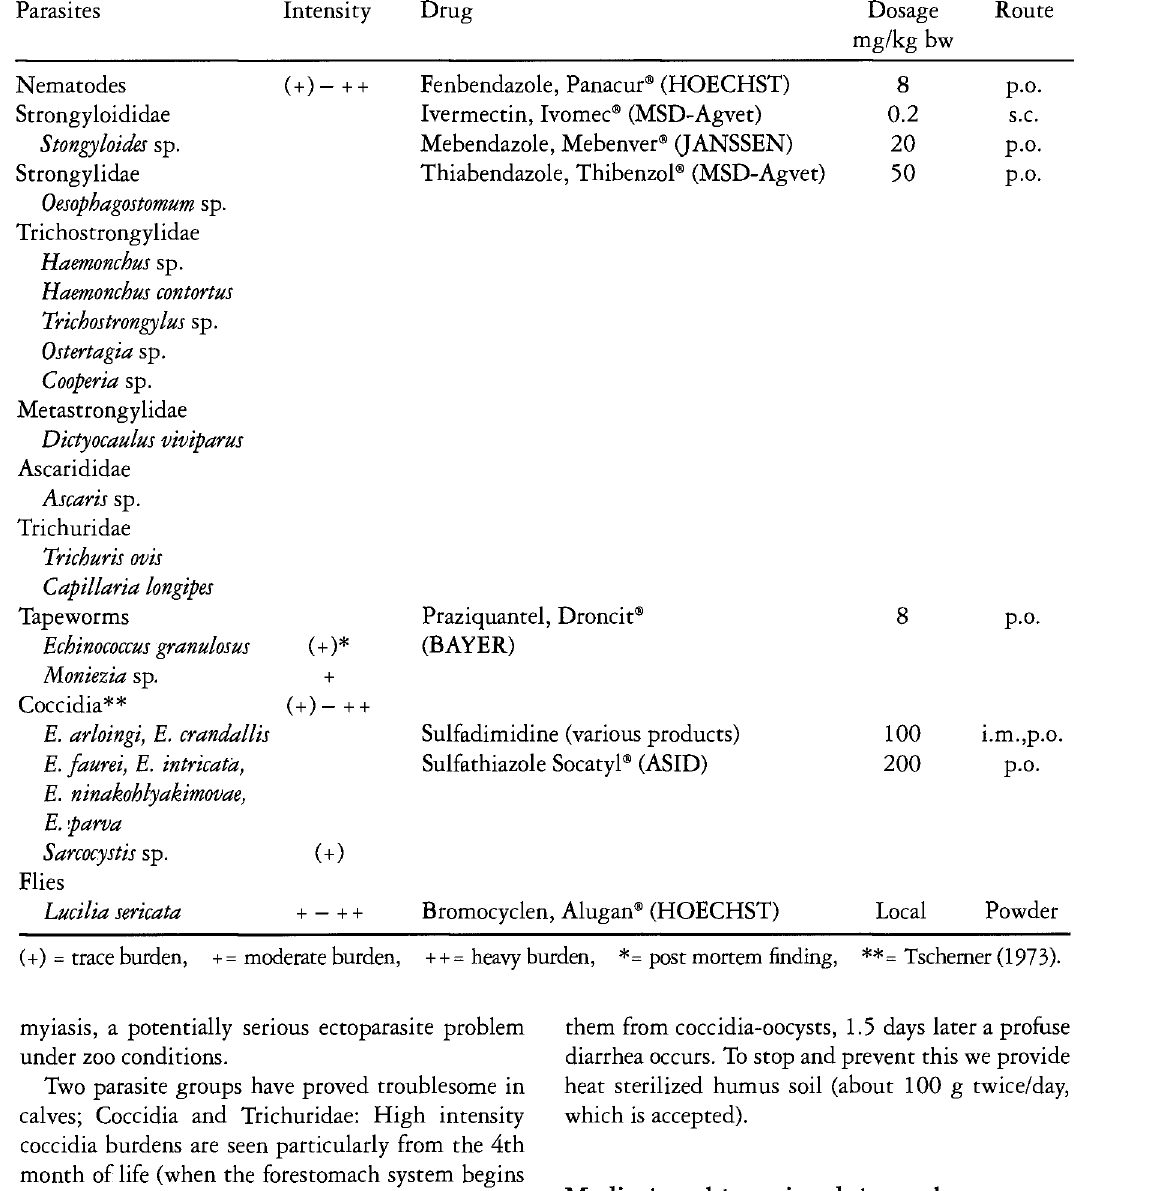
Table 3. Parasitological findings and treatment in muskoxen at Tierpark Berlin-Friedrichsfelde, 1966-1995. Parasites